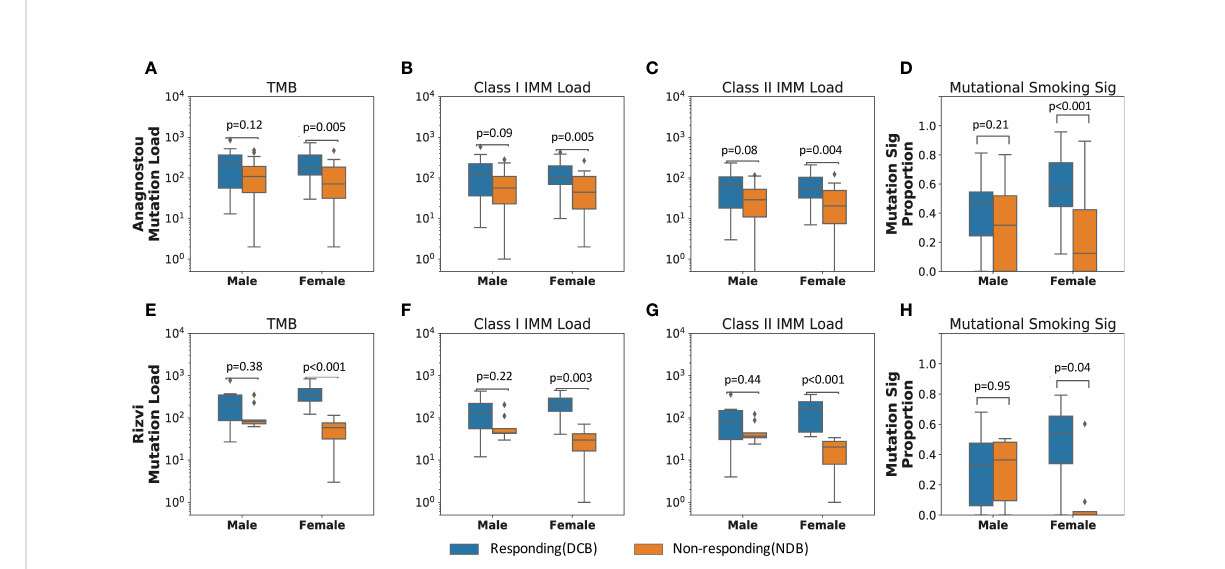
FIGURE 2 Immunogenic mutation load distinguishes responding from non-responding tumors in females who received immune checkpoint blockade. In the primary NSCLC cohort (Anagnostou), (A) female responding tumors harbored signi fi cantly higher TMB than female non-responding tumors (MW p=0.005). Similarly, (B) Class I and (C) class II IMM loads separated female response groups (Class I IMM loads MW p=0.005; Class II IMM loads MW p=0.004), but not male response groups (Class I IMM loads: MW p=0.09; Class II IMM loads: MW p=0.08). (D) Smoking mutational signature levels also only differed in female response groups (MW p=0.0006), but not male response groups (MW p=0.21). These results were corroborated in the validation cohort (Rizvi) with immunogenomic features, (E) TMB, (F) Class I IMM loads, (G) Class II IMM loads, and (H) mutational smoking